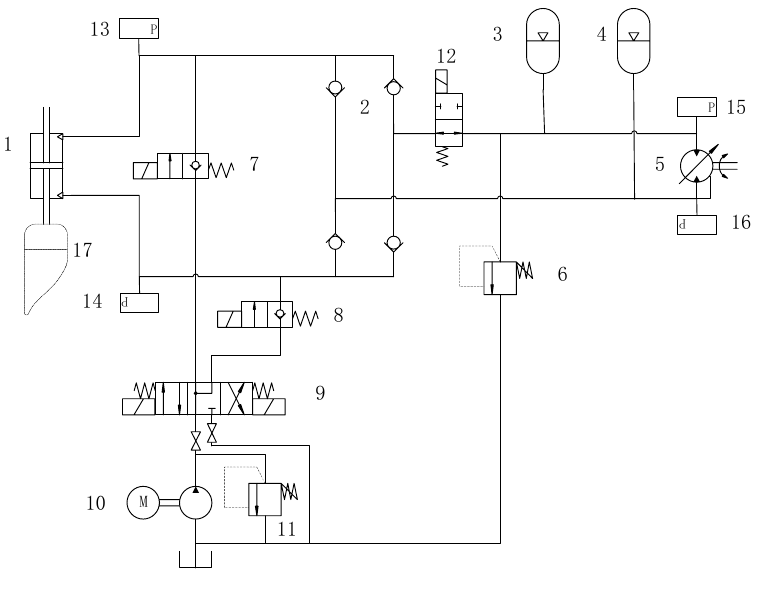
Figure 6. Hydraulic PTO unit circuit diagram.